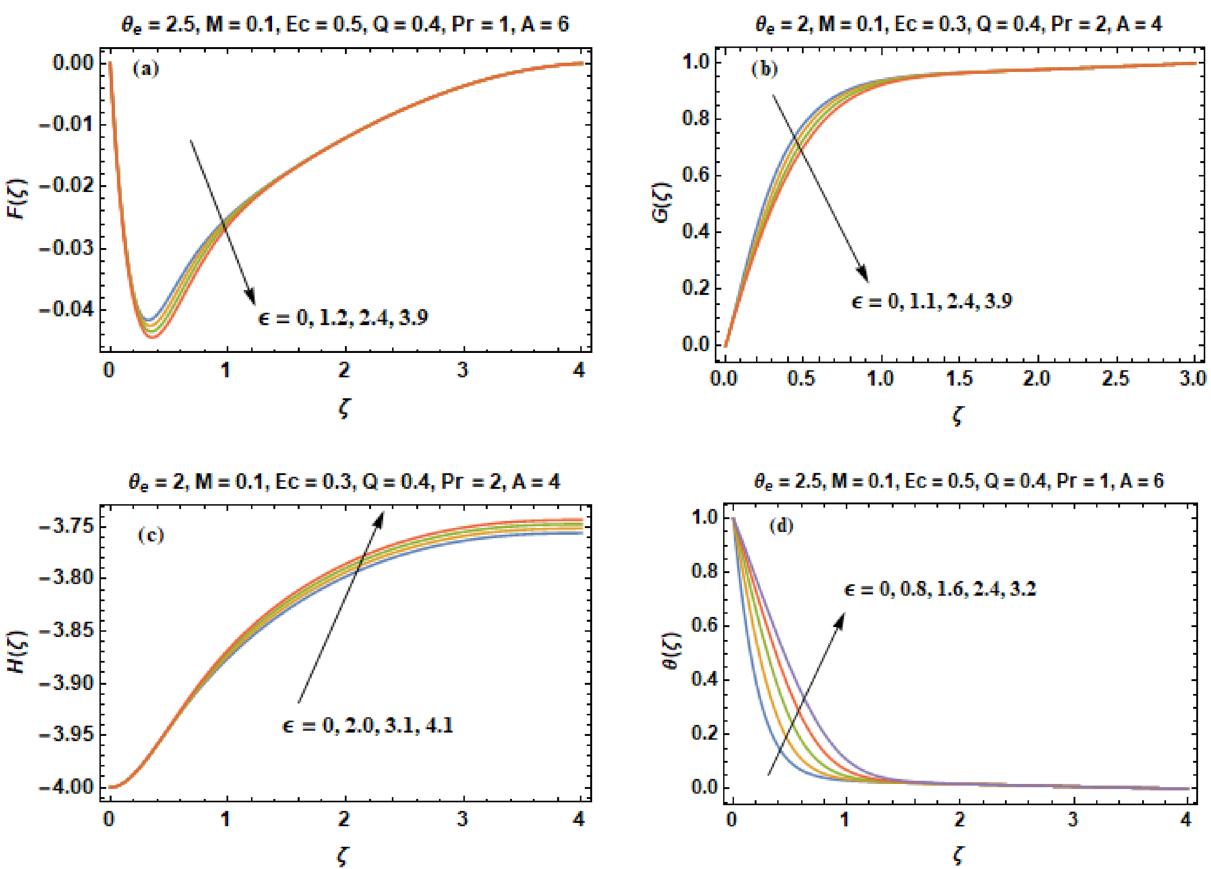
Figure 8. ( a–d ) Components of velocity (F, G, H) & temperature profile (θ) versus parameter of variable thermal conductivity ( ε ) .